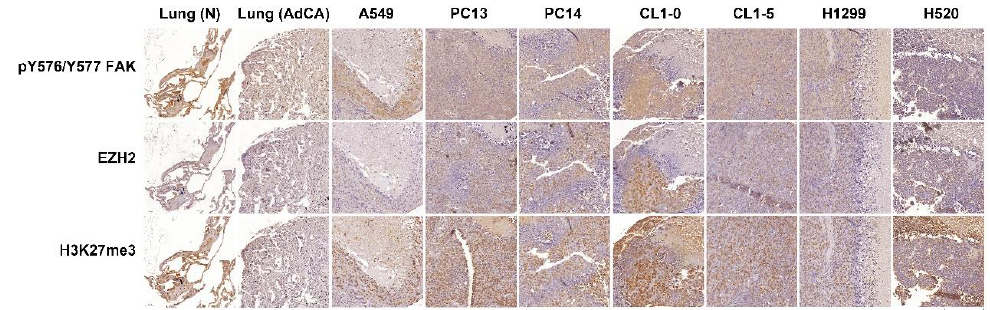
Figure 3. Immunohistochemistry of tissue microarrays reveals the functional relevance between FAK and EZH2 that exists in human non-small cell lung-cancer-cells-developed tumor tissues. Tissue microarray sections were subjected to immunostaining using anti-EZH2, -H3K27me3, and -phospho-FAK antibodies. Comparison of EZH2, H3K27me3, and phospho-FAK expression in normal tissues and tumor tissues from the tumor tissue microarray. (Bar scale: 200 µm) .